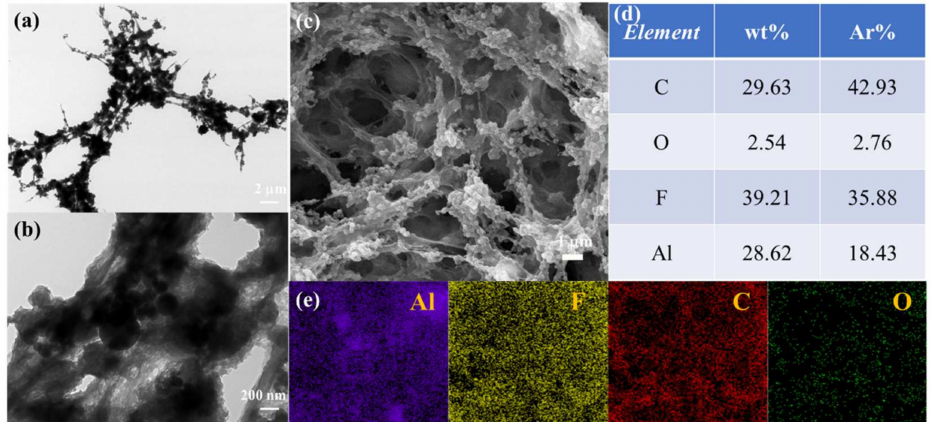
Figure 2. ( a , b ) TEM analysis of I-Al/PVDF fragmentation; ( c ) The original SEM image of EDS area of I-Al/PVDF; ( d , e ) Elemental mapping images of Al, F, C, and O species.